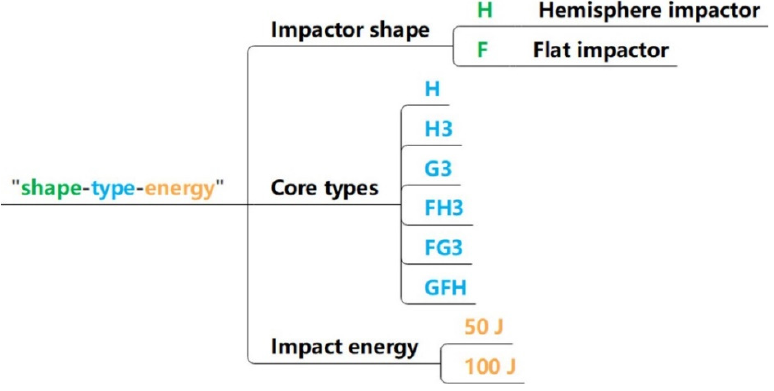
Figure 7. Damage modes of H, H3, and G3 under 50 J impact energy with hemisphere impactor.